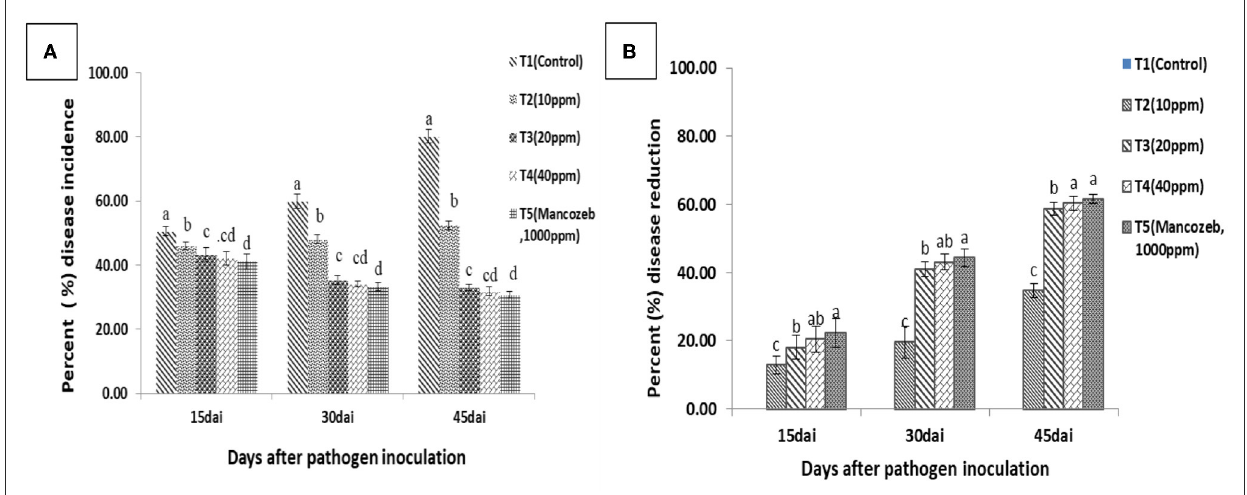
FIGURE12 (A) Disease incidence (DI) and (B) disease reduction in Ag NP-treated tomato plants against early blight of tomato in the field. The results were obtained 15, 30, and 45 days after pathogen inoculation (dapi). Commercial fungicide mancozeb (1,000 ppm) was used as a positive control. Error bars in the figure represent standard deviation (SD) of means. Distinct superscript letters represent data significantly different from other treatments ( p ≤ 0.05; Duncan’s multiple range test).